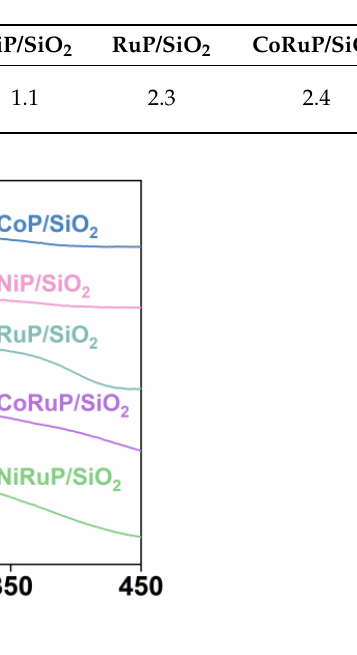
Figure 5. NH 3 -TPD profiles of the